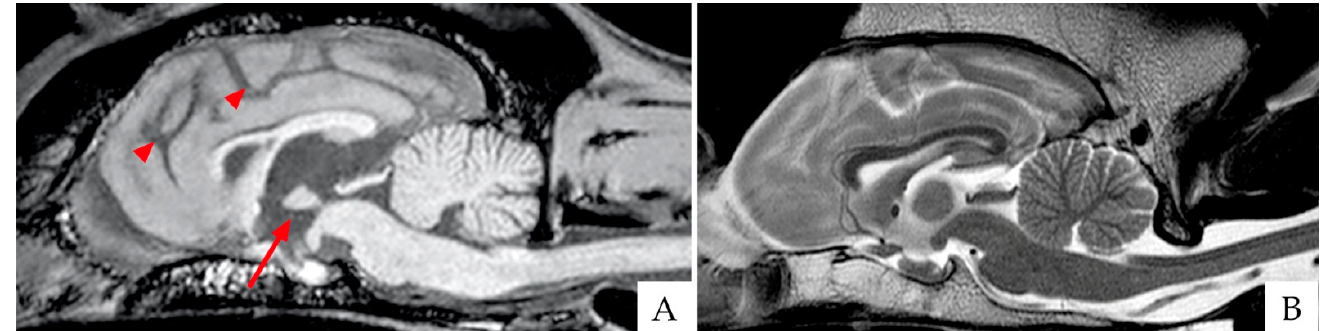
Figure 2. Brain scans of two breed ‐ matched old dogs affected ( A ) and unaffected ( B ) by CDS, as acquired with 3 Tesla magnetic resonance imaging (3T MRI). ( A ) Sagittal T1 weighted image (T1WI). Please note the reduced size of the interthalamic adhesion (arrow) and the increased sulci (arrowheads). ( B ) Sagittal T2WI of the normal control dog.